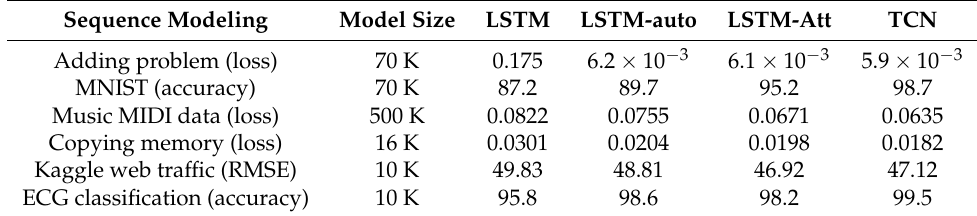
Table 2. Test results for different tasks with the proposed